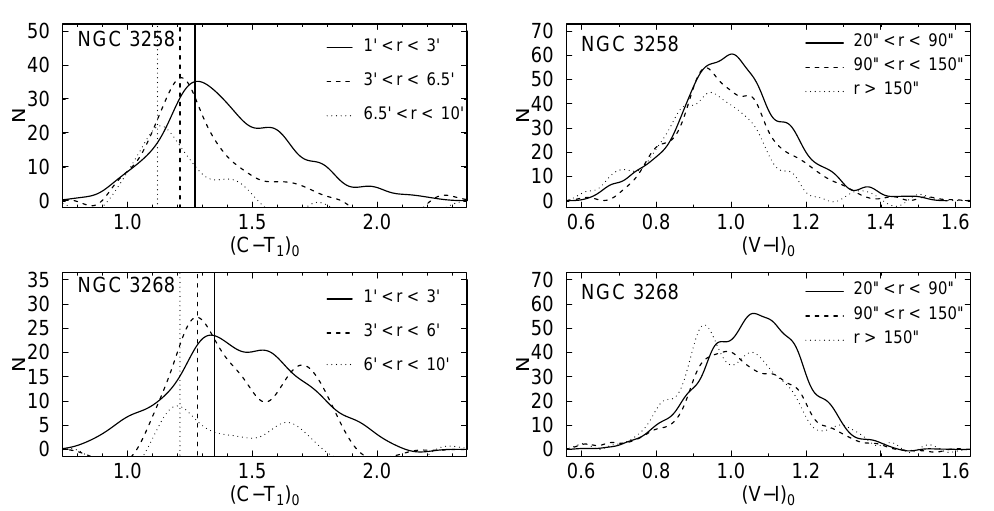
Figure 4. Left panels : smoothed colour distributions for GC candidates from MOSAIC data, split in three radial distance regimes. Vertical lines indicate mean colours for the blue subpopulation, obtained with Gaussian mixture modeling (GMM) [24]. Right panels : analogue figures for GC candidates from FORS1